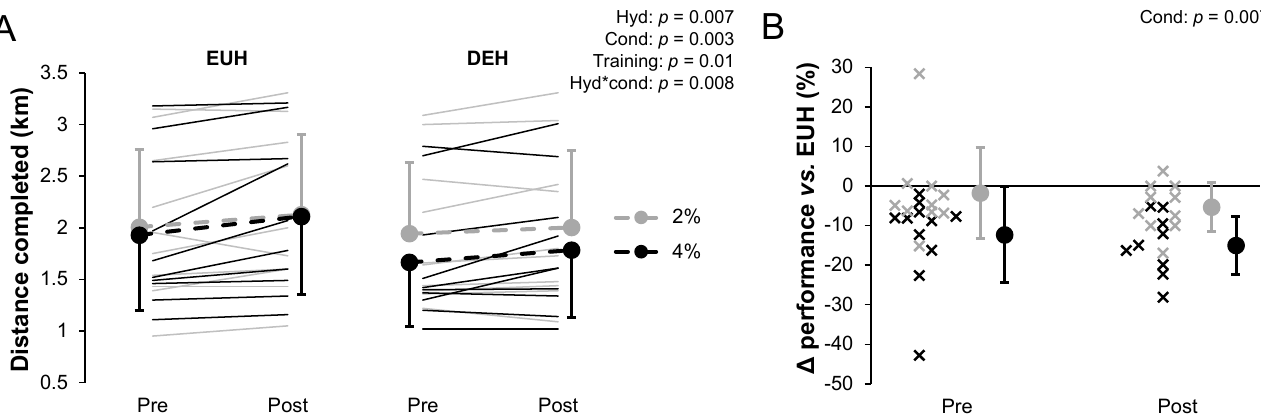
Figure 4. Distance completed during the 12 min time-trial ( A ) and percent performance difference ( B ) while replacing or not 2 or 4% body mass losses, pre- and post-training. ∆ = difference. Values are the means ± SD. EUH = euhydrated; DEH = dehydrated; Cond = condition (2 vs. 4%); Hyd = hydration (EUH vs. DEH); Training = pre vs. post. Only the significant effects are reported.